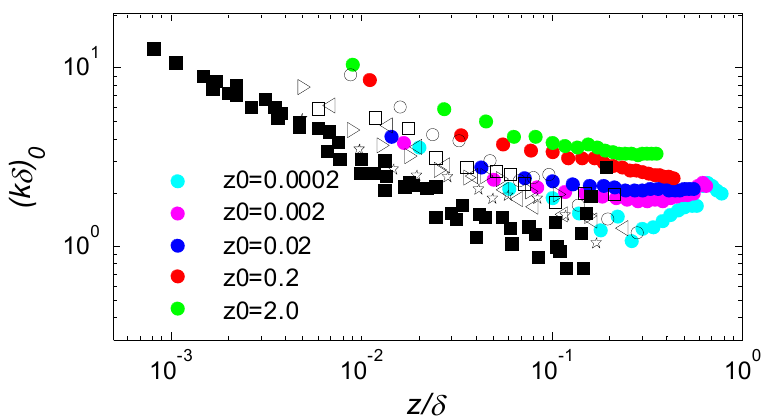
Figure 11. Variation in the peak wavenumber of VLSMs with height. The solid colored circle is the current simulation data, the open symbols show the field-measured data of Wang and Zheng [9], and the solid black symbols represent the experimental data of Valliviki et al. [46].